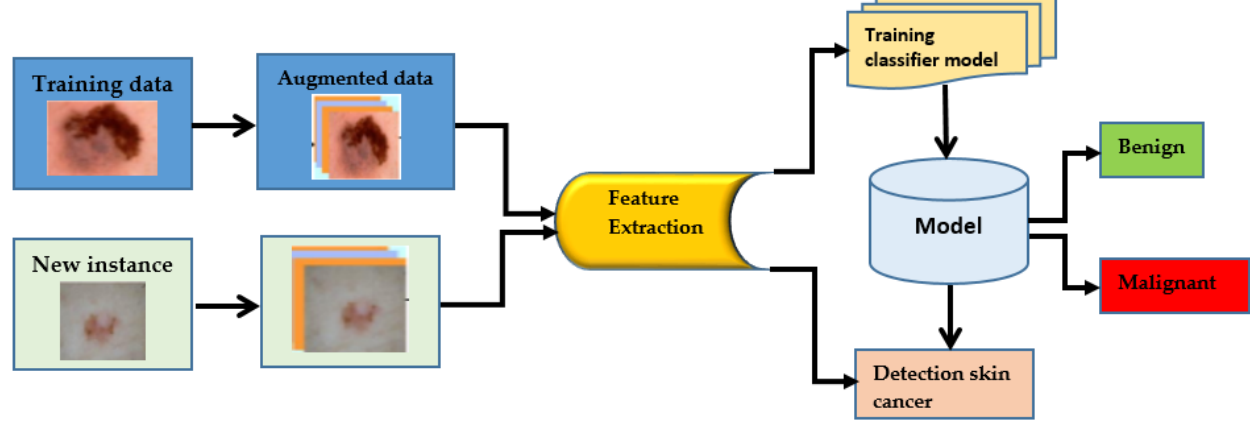
Figure 1. Process of cancer detection.